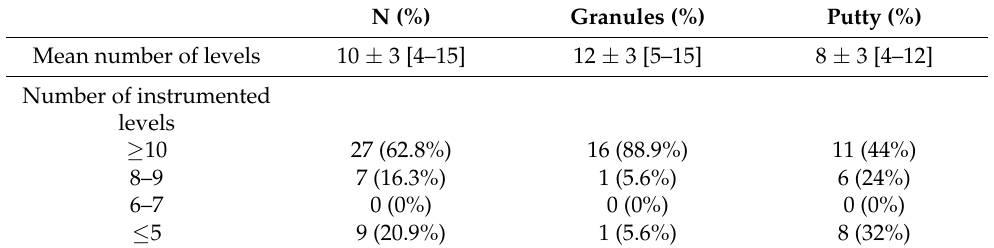
Table 2. Distribution of the number of instrumented